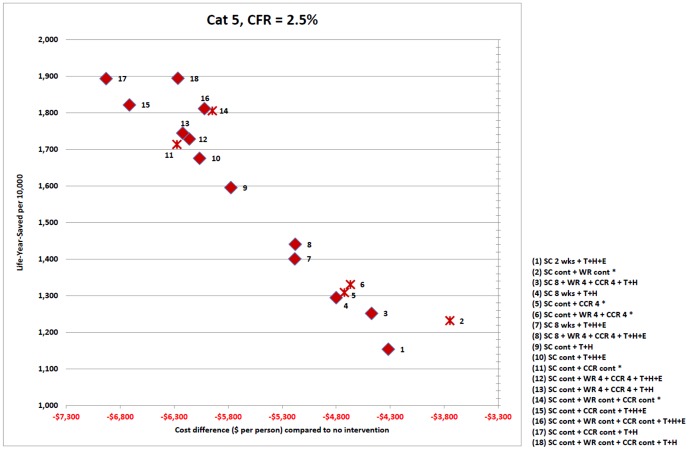
Intervention strategy cost effectiveness plane for severity category 5 with death related productivity losses.Cost effectiveness for each intervention strategy is plotted as a point in a two-dimensional plane for severity category 5 (case fatality ratio 2.5%). Horizontal axis represents the cost of the intervention strategy as a difference in total cost between two scenarios; an outbreak with the intervention in place and an outbreak with no interventions, expressed as dollars per member of the population. Vertical axis represents the number of life years saved by each strategy: the difference in life years lost for an outbreak with and without the strategy in place, expressed as life years saved per 10,000 population members. Both costs (death related productivity losses) and LYS are discounted. Strategies involving antiviral drugs are marked as diamonds; purely social distancing strategies are indicated with a cross. Each strategy is numbered, with the intervention components and durations making up the strategy given in the legend within the figure. Interventions are abbreviated as follows: SC – school closure; CCR – 50% community contact reduction; WR – 50% workforce reduction; 4, 8 – intervention duration in weeks; cont – continuous duration; T – antiviral treatment of diagnosed symptomatic cases; H – antiviral prophylaxis of household members of diagnosed symptomatic cases, E – antiviral prophylaxis of school class or workplace contacts of diagnosed symptomatic cases.